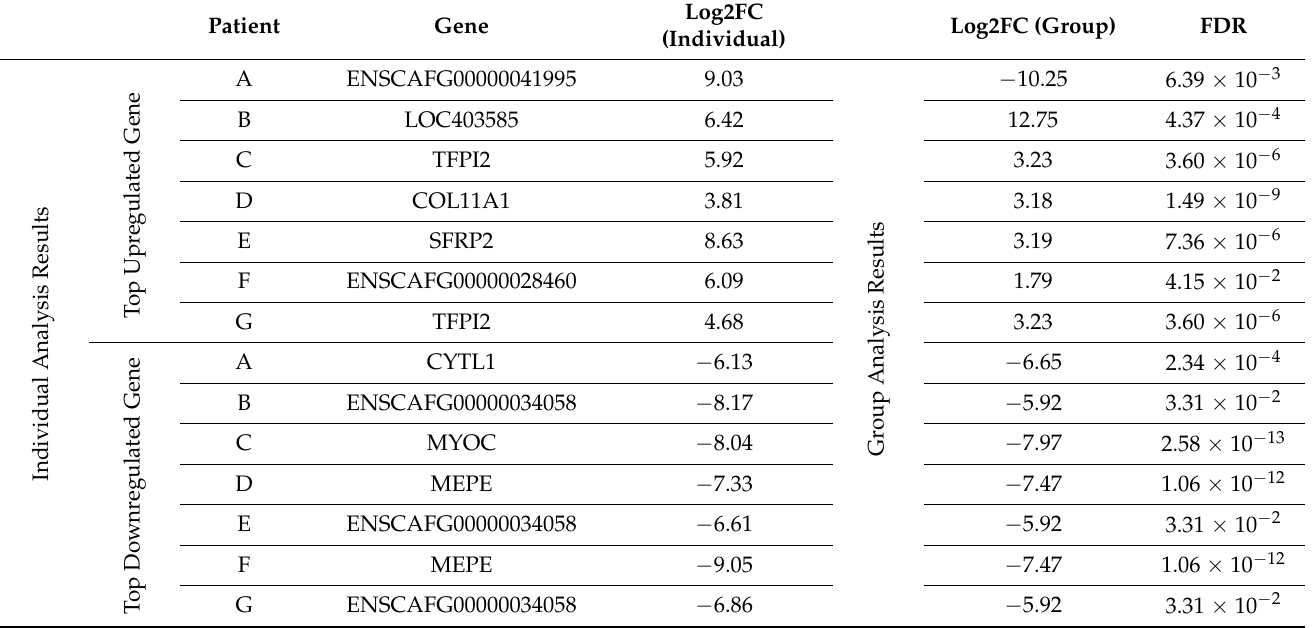
Table 3. Comparison of individual-level analysis with group analysis results. The top up- and downregulated gene for each patient according to log2 fold-change values from individual analy- sis shows some similarities to group analysis results. The top upregulated gene in patient A (EN- SCAFG00000041995) shows distinct opposition in terms of direction of fold-change in the group results. Patient Gene